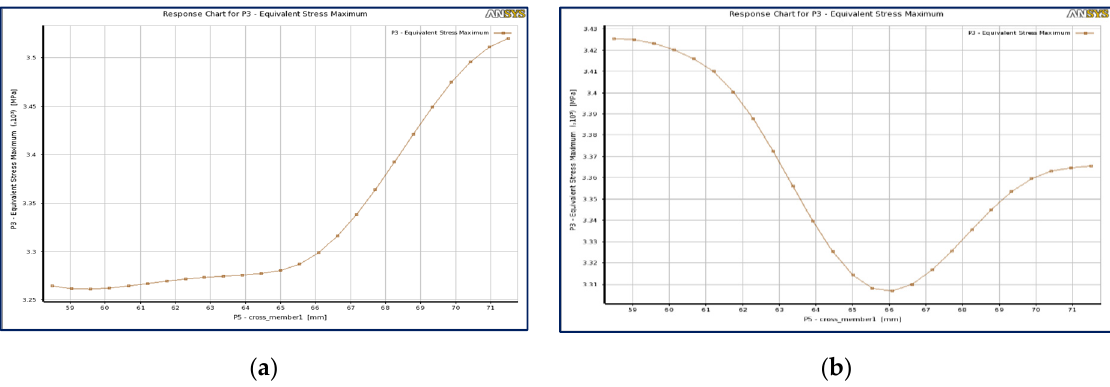
Figure 20. Equivalent stress cross member 1 ( a ) for CCD scheme, and ( b ) for optimal space filling (OSF) design.